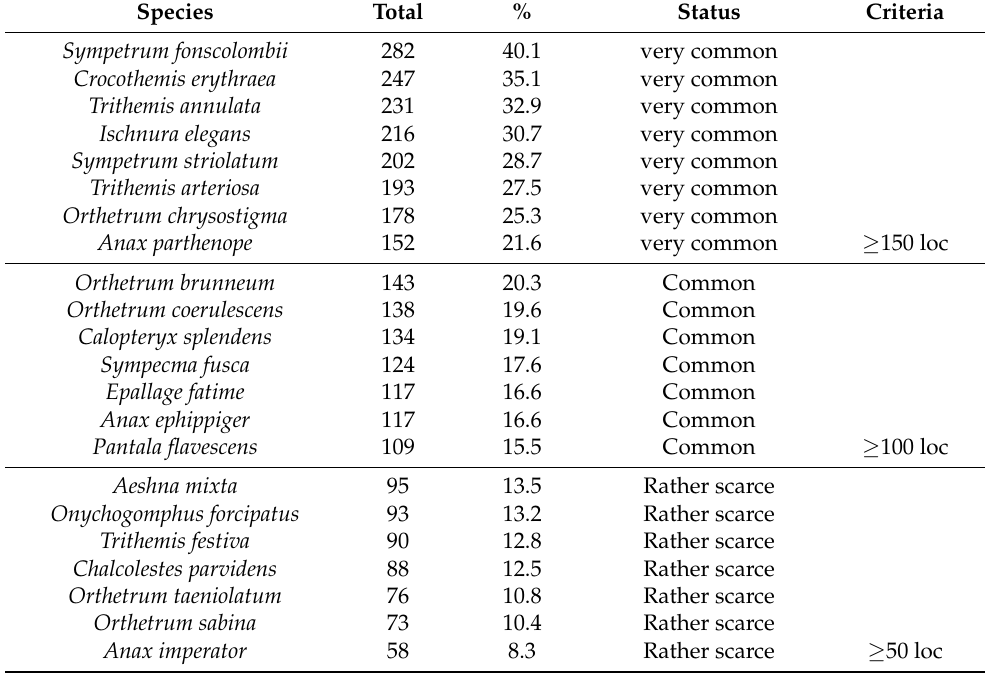
Table 2. Status of the dragonflies and damselflies of Cyprus, based on the total number of sites (N max = 703) where a species was observed during